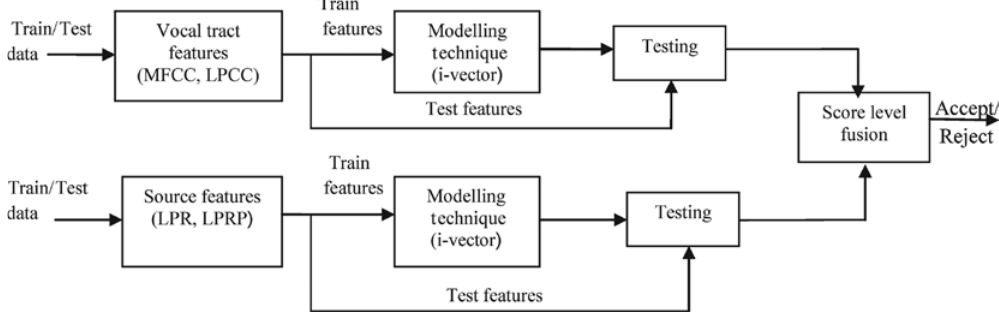
Figure 3: Block Diagram of Score-Level Fusion for Different Feature Extraction